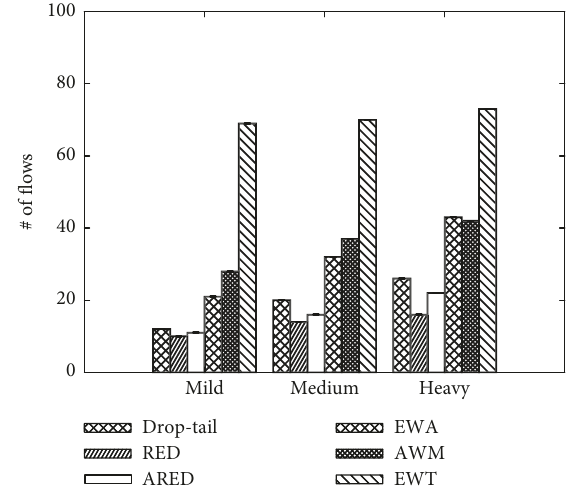
Figure 17: Number of flows needed to meet RFC 7928 in Scenario